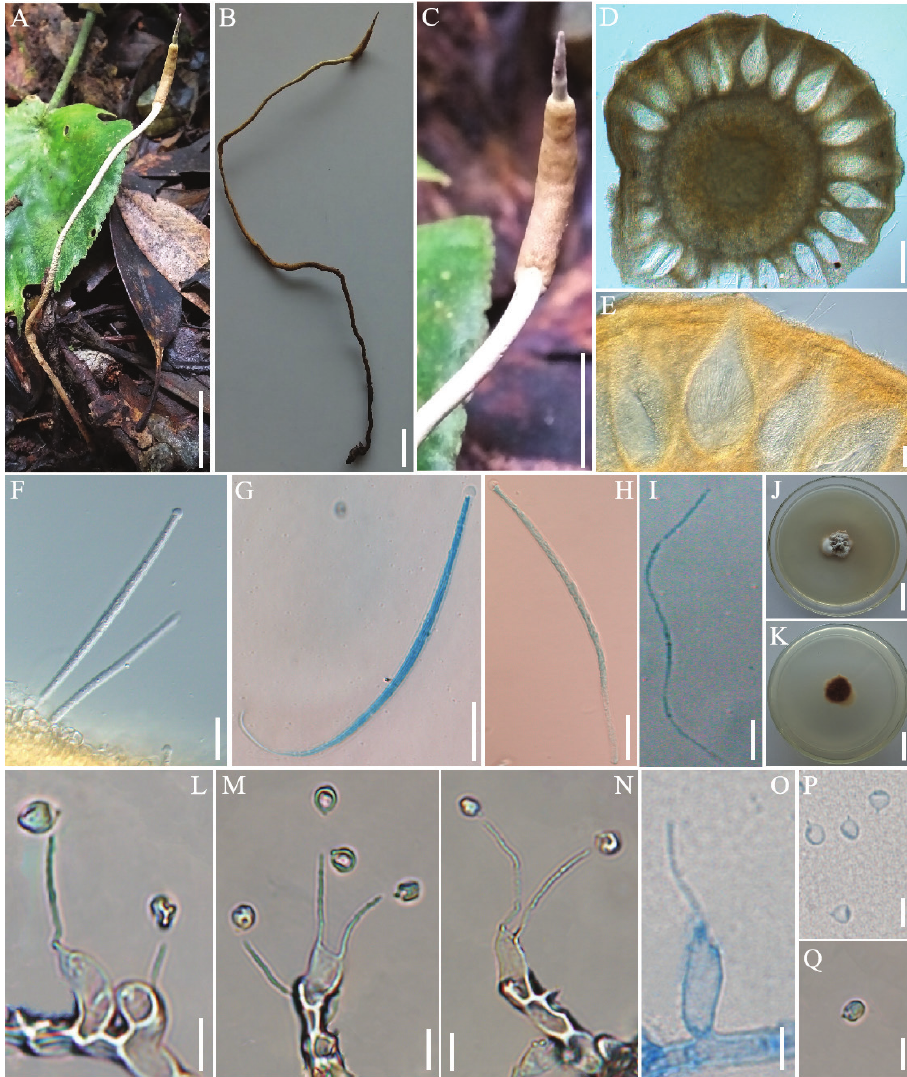
Figure 3. Ophiocordyceps bidoupensis A–C fungus on an Elateridae larva D, E cross-section of the ascoma showing the perithecial arrangement F–H asci I ascospores J, K colony on PDA medium L–N conidiog- enous cells and conidia O conidiogenous cells P, Q conidia. Scale bars: 1 cm ( A–C ); 200 µm ( D ); 20 µm ( E–H ); 10 µm ( I ); 2 cm ( J, K ); 5 µm ( L–Q